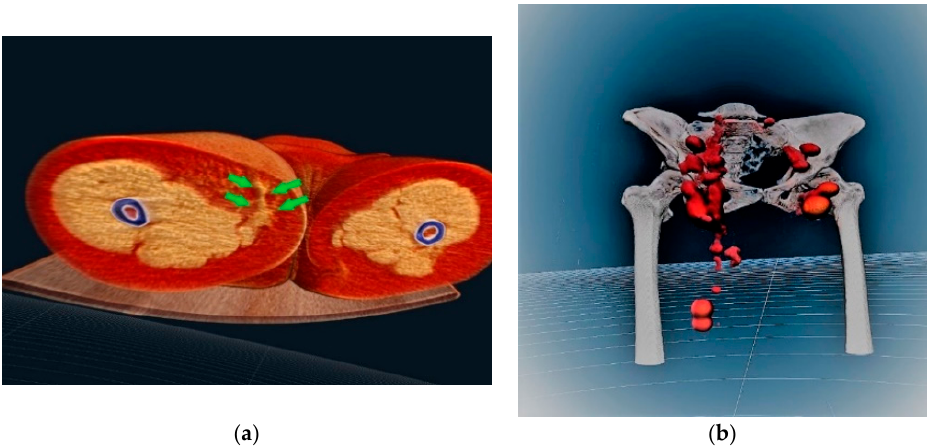
Figure 3. ( a ) 3D constructed model based on the fusion of the radiographic images and obtained by virtual reality software showing the lymphatic malformation (green arrows) ( b ) 3D reconstructed hybrid image of the SPECT-CT and lymphoscintigraphy obtained by virtual reality software: visualization of the lymphatic structures of the lower limbs. Note the extension of the malformation (conglomerate of tracer) from the region of the right thigh up to the abdominal cavity.